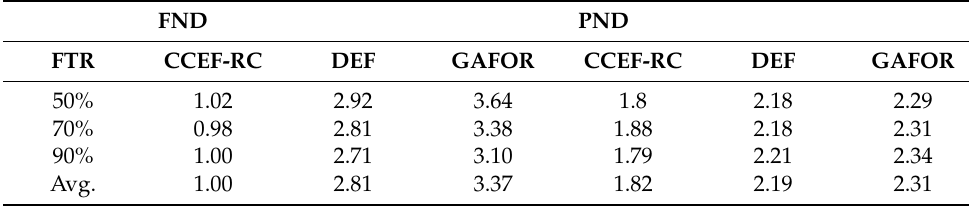
Table 4. Network Lifetime—FND and PND.